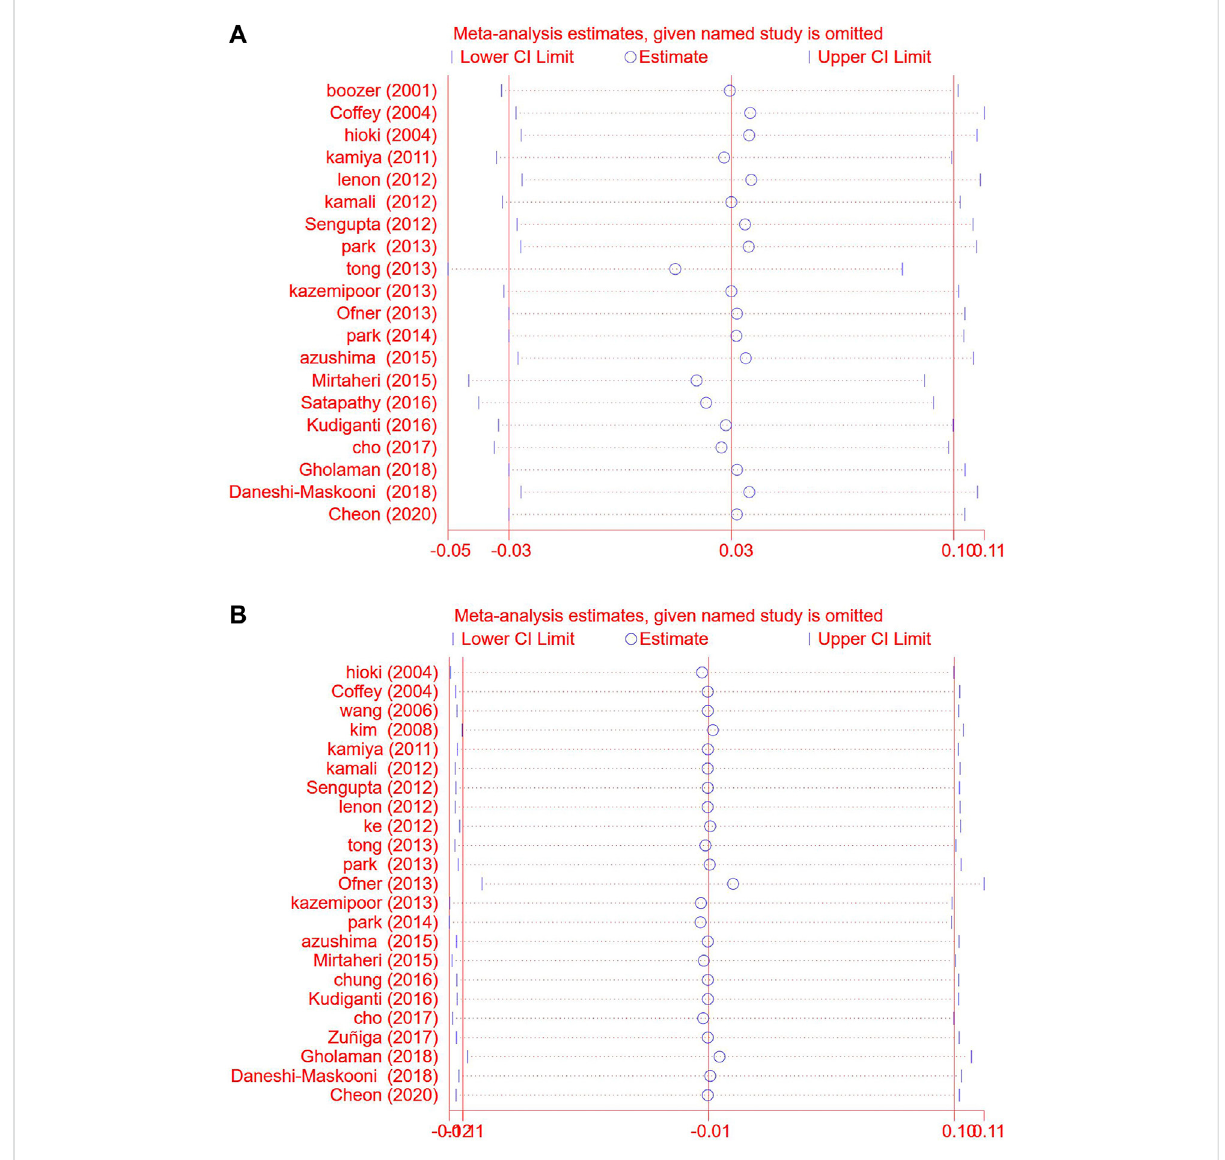
FIGURE 17 .Sensitivity analysis chart. Comparison: TCM treatment placeo or blank control. (A) Sensitivity analysis chart of weight. (B) Sensitivity analysis chart of